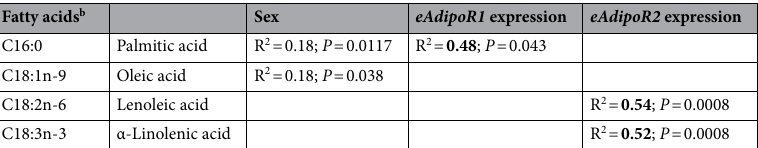
Table 10. Regression of Fatty Acid levels in emu oil collected in November on sex and November gene expression a . a Data analysed by mixed model Multiple Regression treating sex as a binary variable (see Statistical Model 3 in “Methods” section). Non-significant variables were removed from the model for final analysis. Bold R 2 values indicate negative regression. See also Supplemental Fig. 2. b C6:0, C14:0,